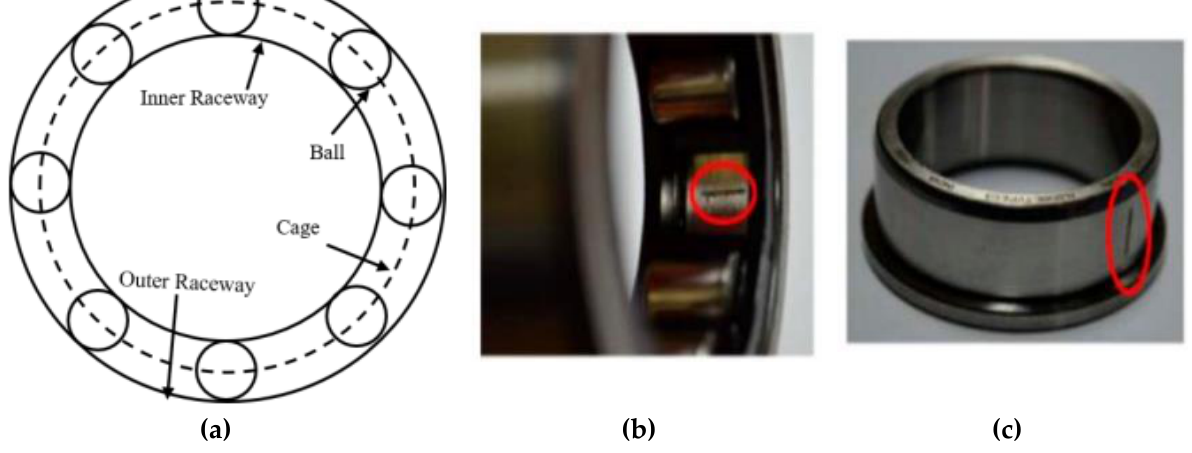
Figure 1. ( a ) Basic bearing geometric structure. Fault in the ( b ) outer race and ( c ) inner race.